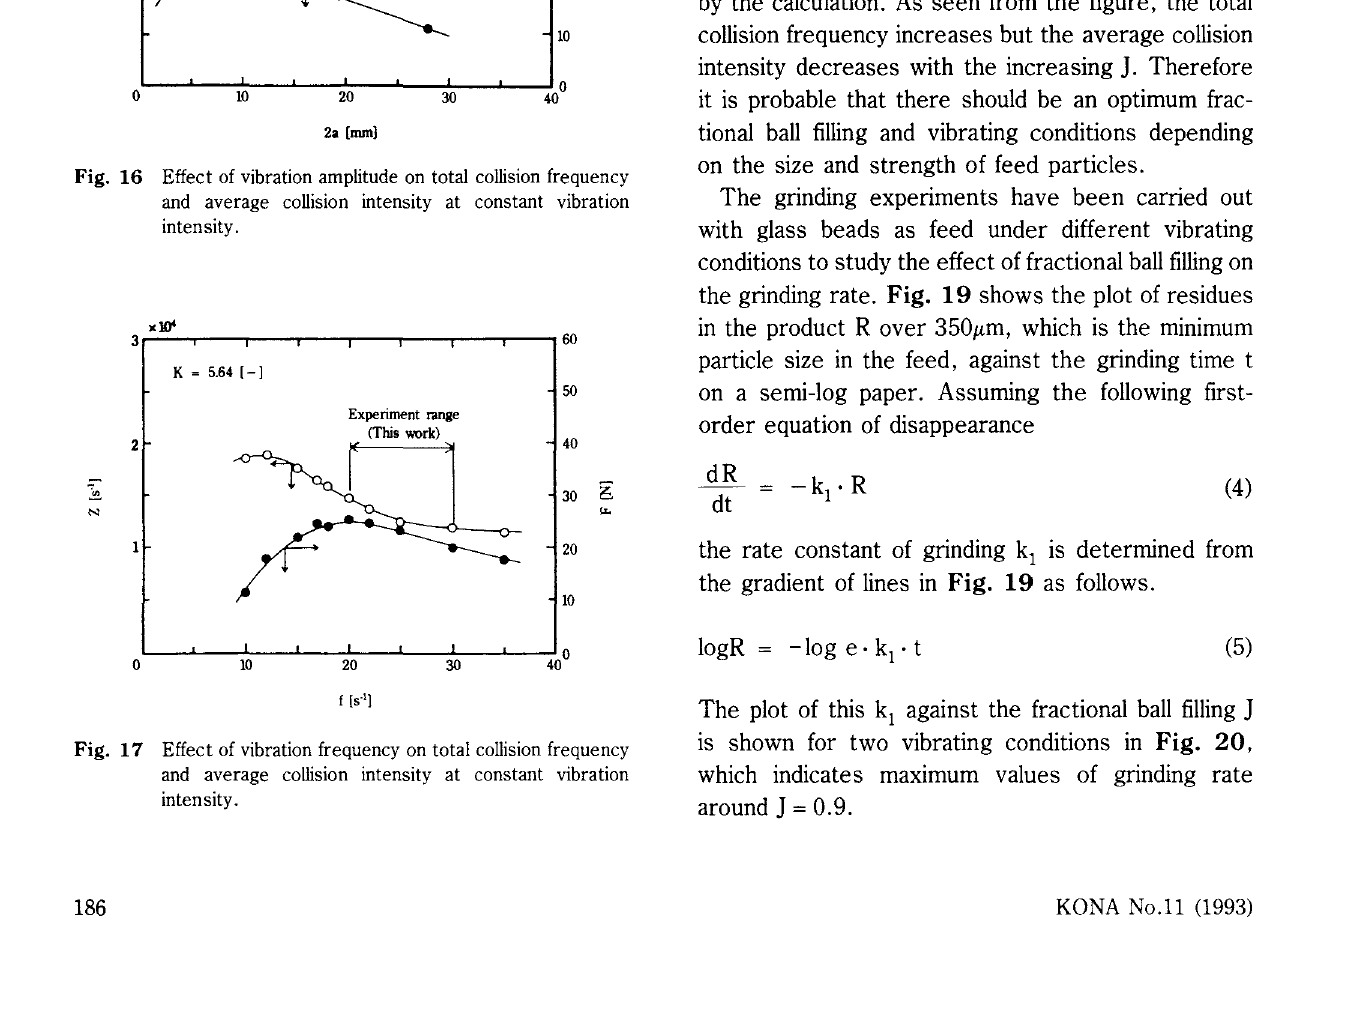
Fig. 18 Effect of fractional ball filling on average intensity and total frequency of ball